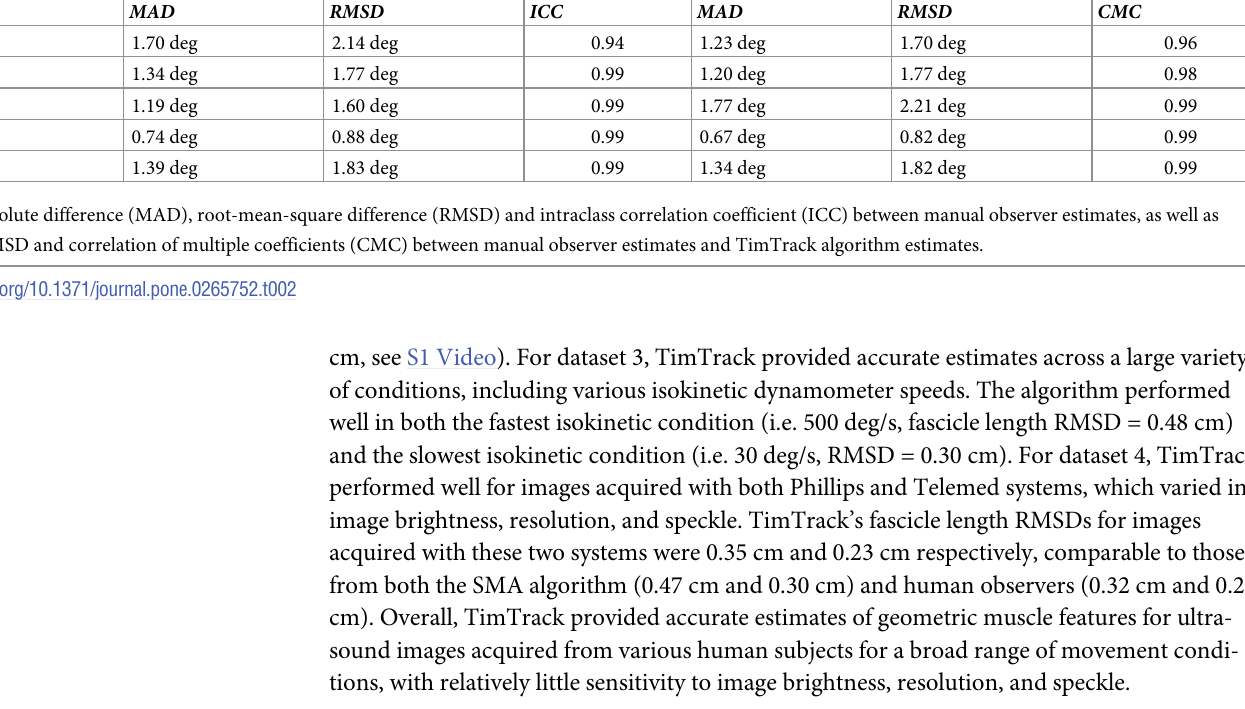
Table 2. Pennation angle. Manual-manual differences Algorithm-manual differences